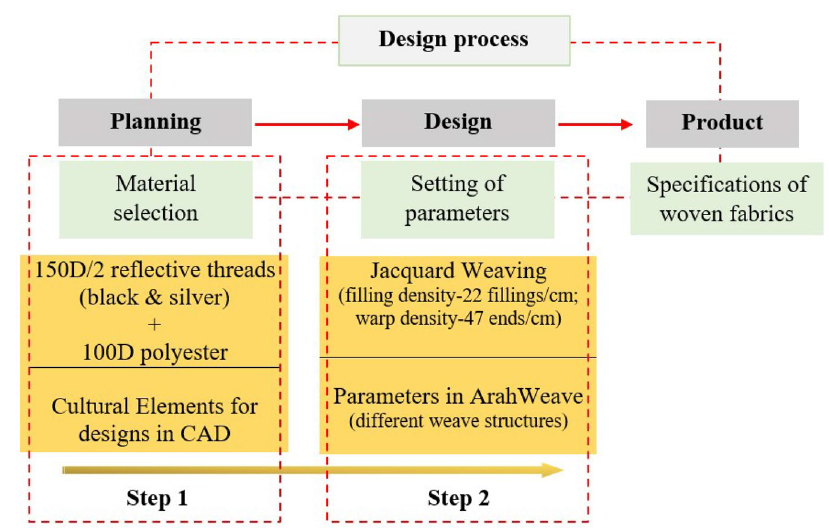
Fig. 4 Stages for jacquard weaving of reflective woven textiles inspired by African art forms (Authors Own